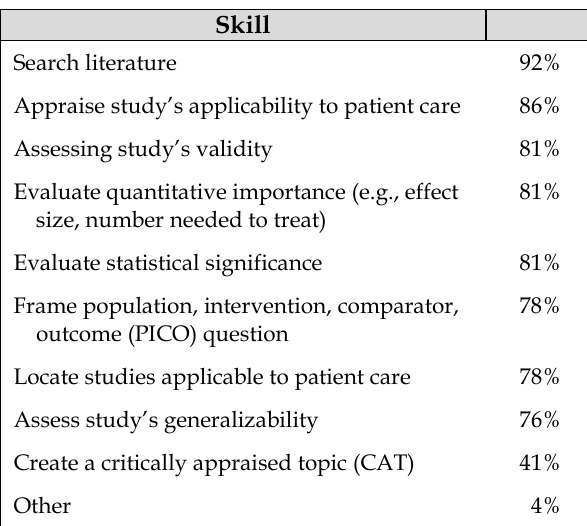
Table 2 Evidence-based medicine (EBM) skills taught